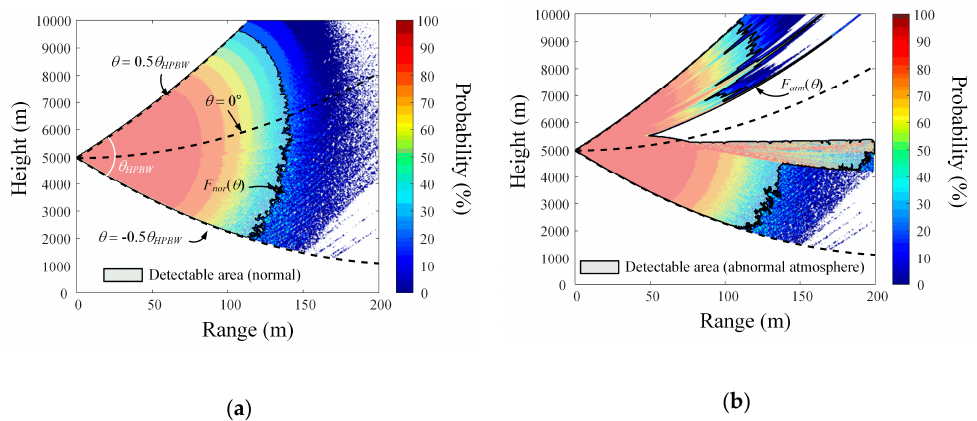
Figure 8. Detectable area according to the target detection probability: ( a ) normal atmosphere; ( b ) abnormal atmosphere.